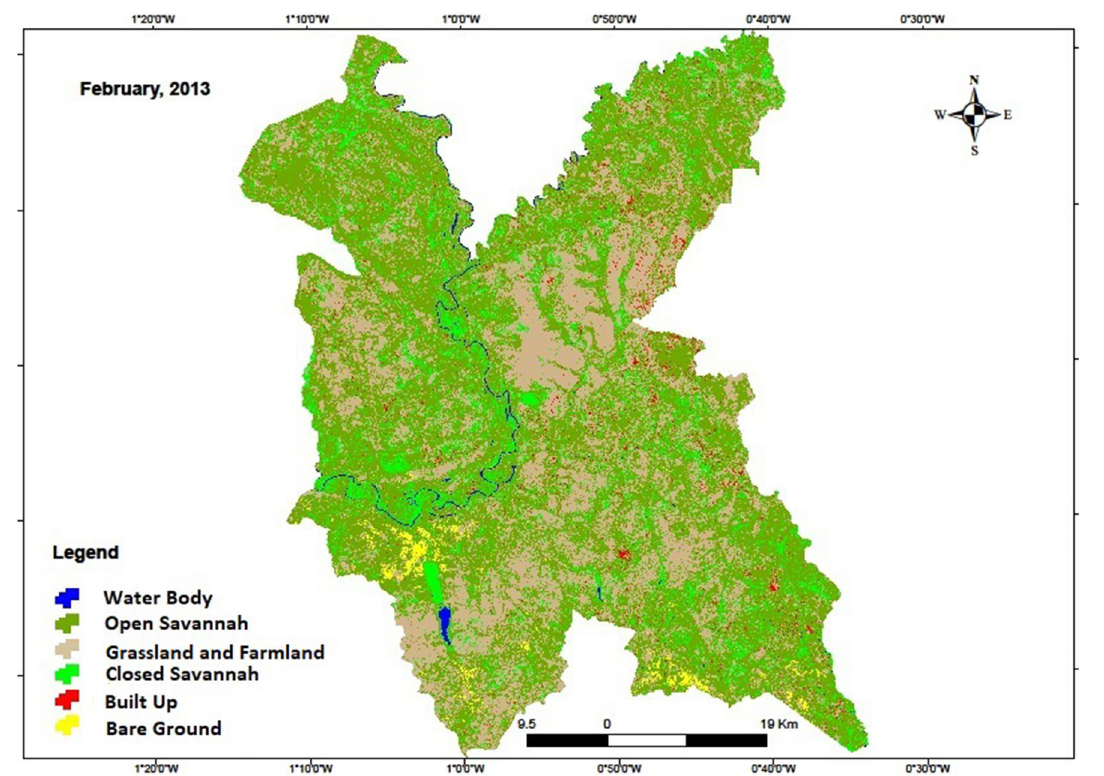
Fig. 6 Land use and land cover map of the Nawuni Catchment in